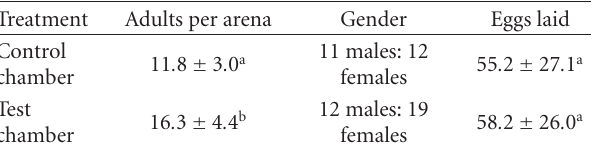
Table 3: E ff ects of attractant (methyl salicylate) on the mean ± SEM number of C . maculata adults and eggs in control and test chambers of